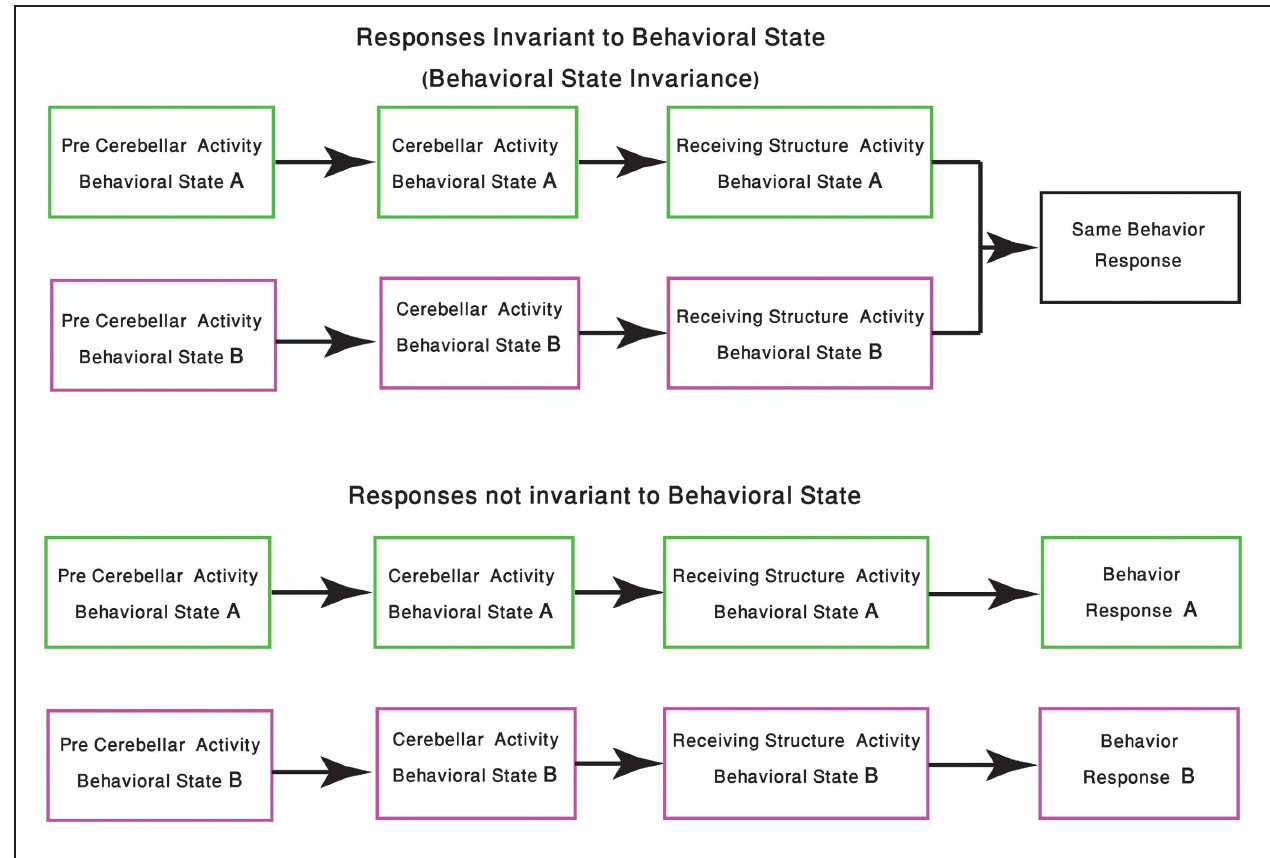
differ. In both behavioral states the cerebellum produces an output, received by other structures in the CNS, resulting in the animal having the same behavioral response. The lower panel describes a scenario in which the behavioral response should be different. Neuromodulation processes, occurring in different states, should be able to select the behavioral responses which are kept